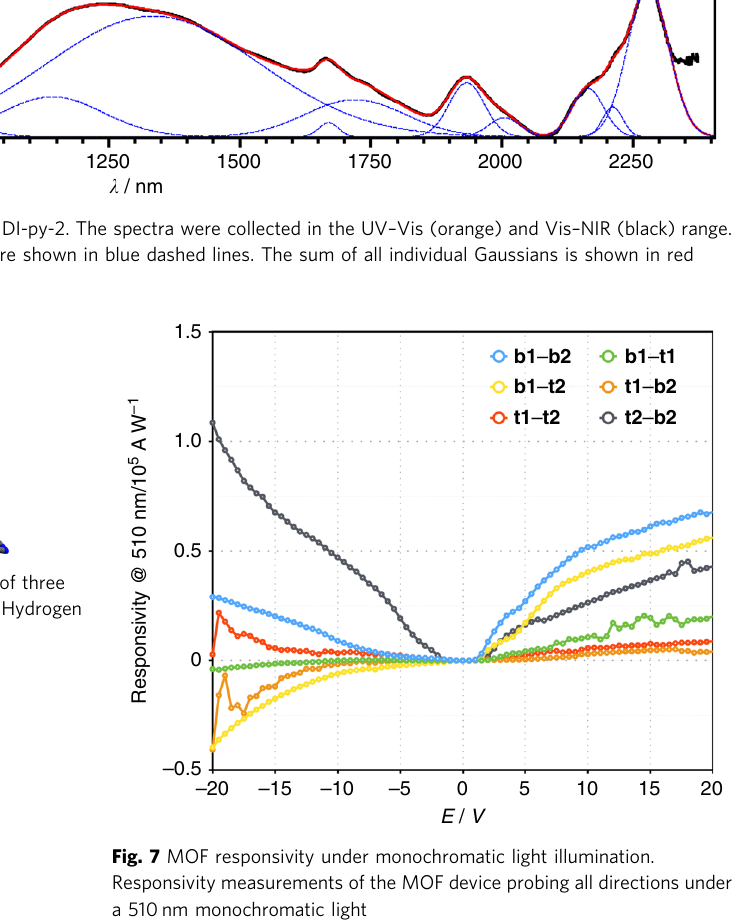
Fig. 7 MOF responsivity under monochromatic light